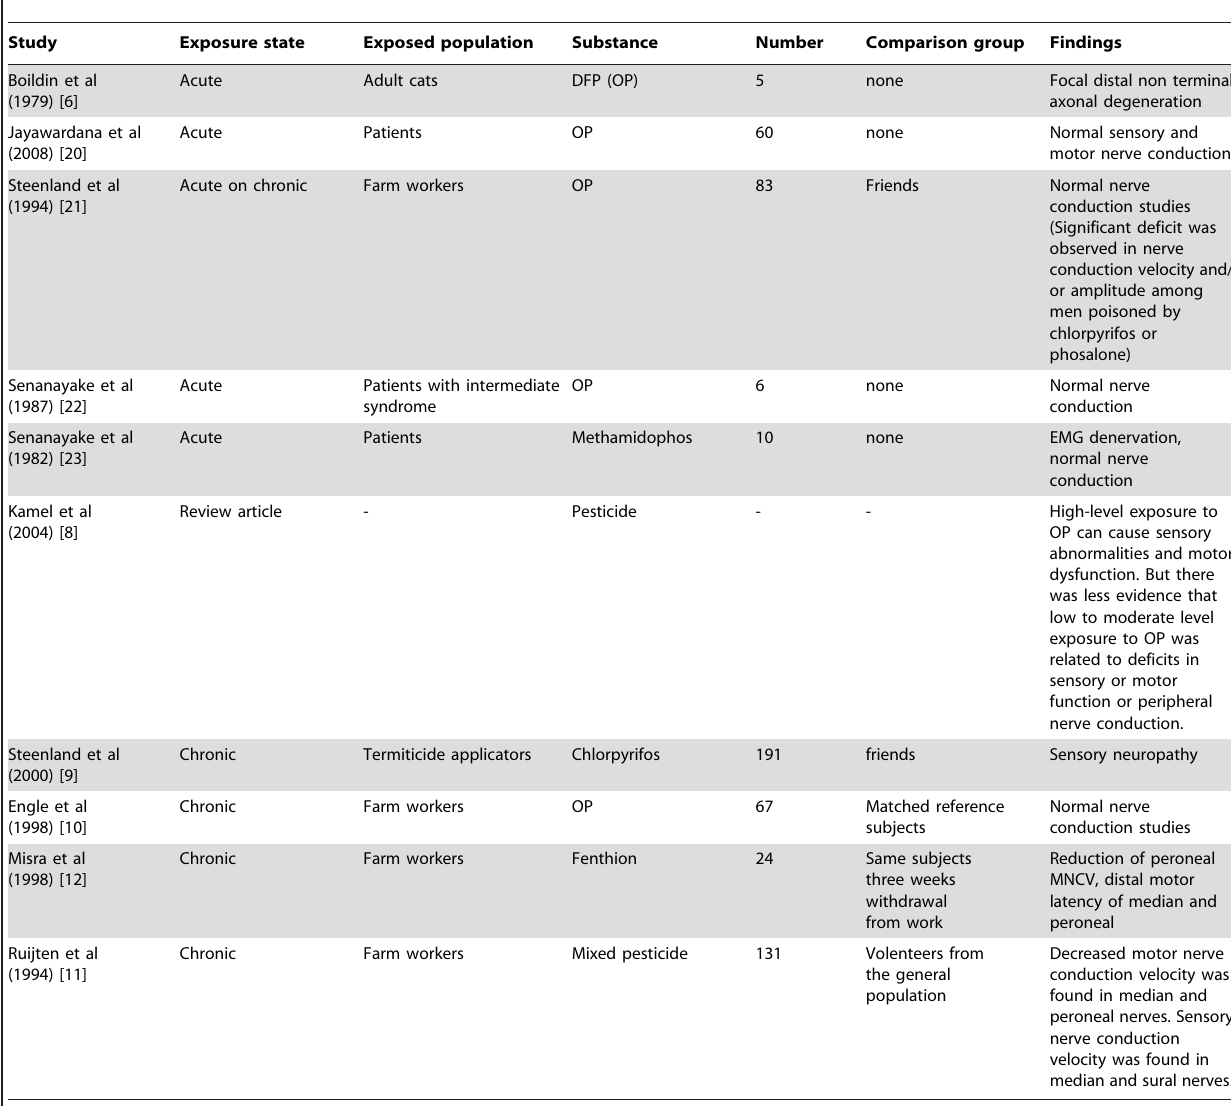
Table 8. Studies of pesticide exposure and peripheral nerve